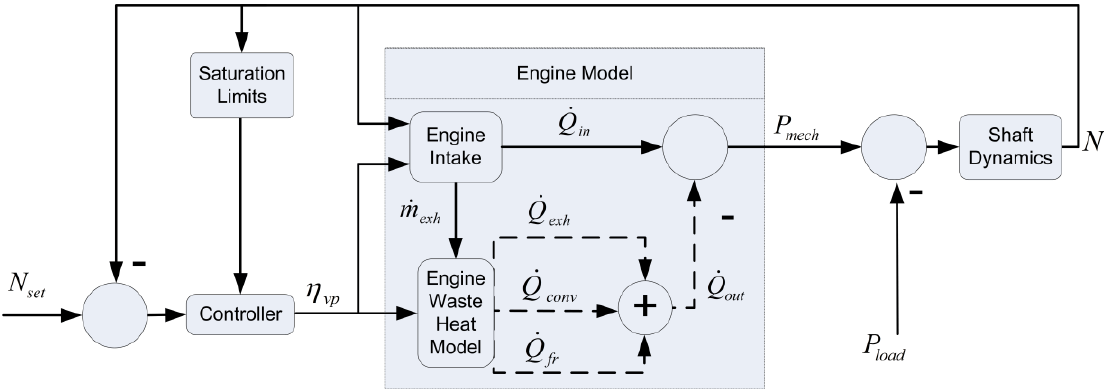
Figure 1. Block diagram of the proposed engine model.